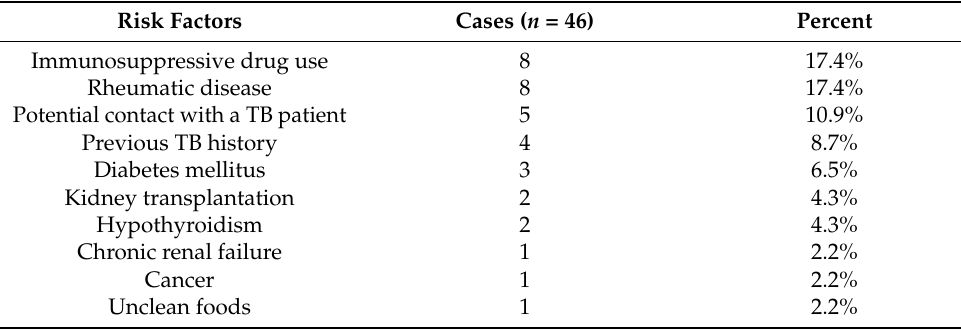
Table 2. The risk factors of patients with intestinal tuberculosis. TB: tuberculosis.